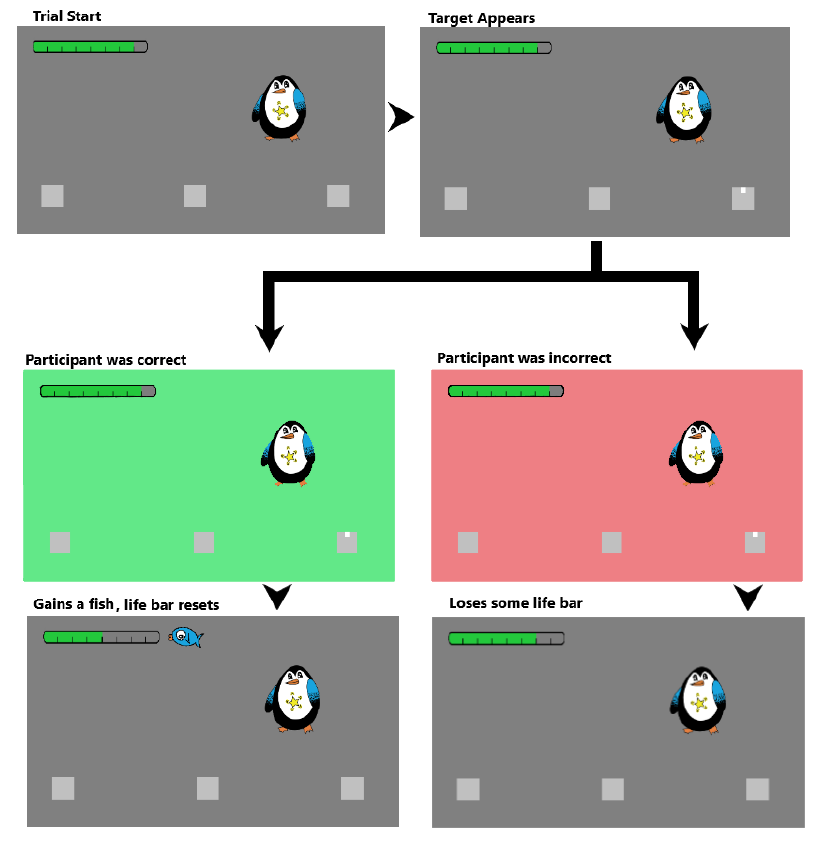
Figure 2. An example trial sequence where the life bar starts one “tick” away from the maximum. A correct response gains the participants a fish reward and the bar returns to the mid-point ( left ). An incorrect response leads to a loss of one “tick” from the life bar ( right